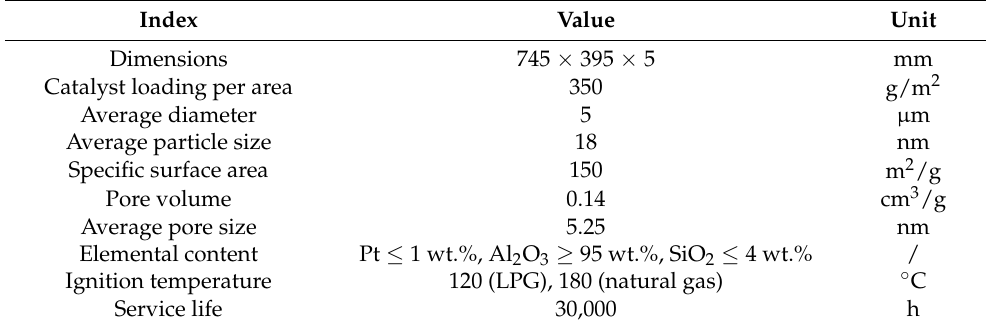
Table 2. Physical properties of fiber-supported noble metal catalyst (Cat-1).